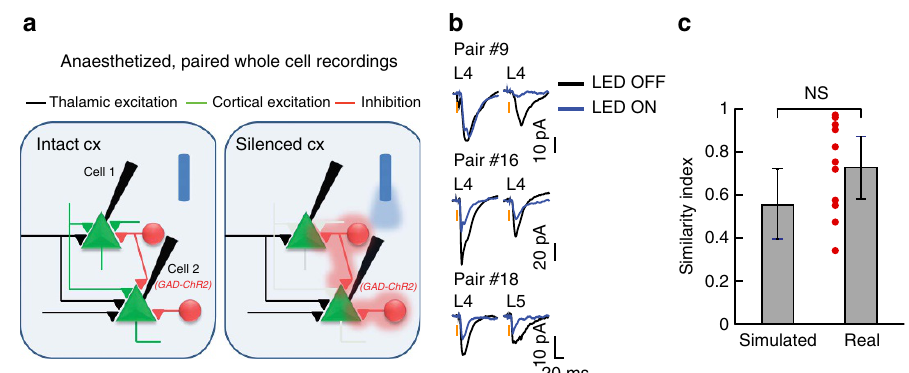
Figure 2 | Thalamic contribution in nearby cortical cells is unequal. ( a ) Schematic illustra1tion of paired whole cell recordings. ( b ) Average whisker- evoked excitatory currents in two example L4 cells recorded independently during LED ON and LED OFF conditions and below an example of an L4–L5 pair. ( c ) The similarity index (SI) of thalamic contribution ( ± s.e.m) for the 11 recorded pairs compared with the expected mean SI in simulated pairs from single cell recordings (bootstrap analysis, see the ‘Methods’ section).